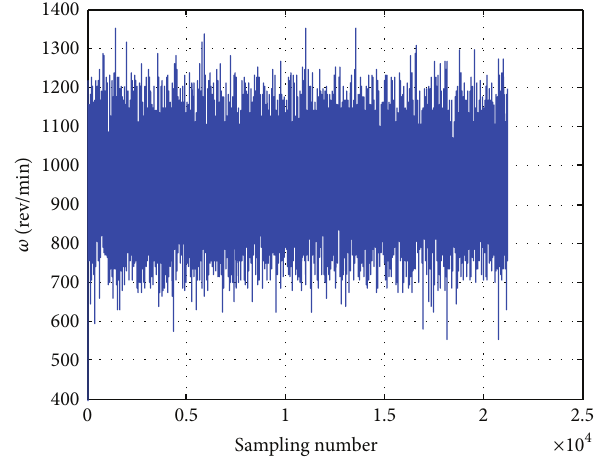
Figure 19: 𝜔 for controlled suspension system.